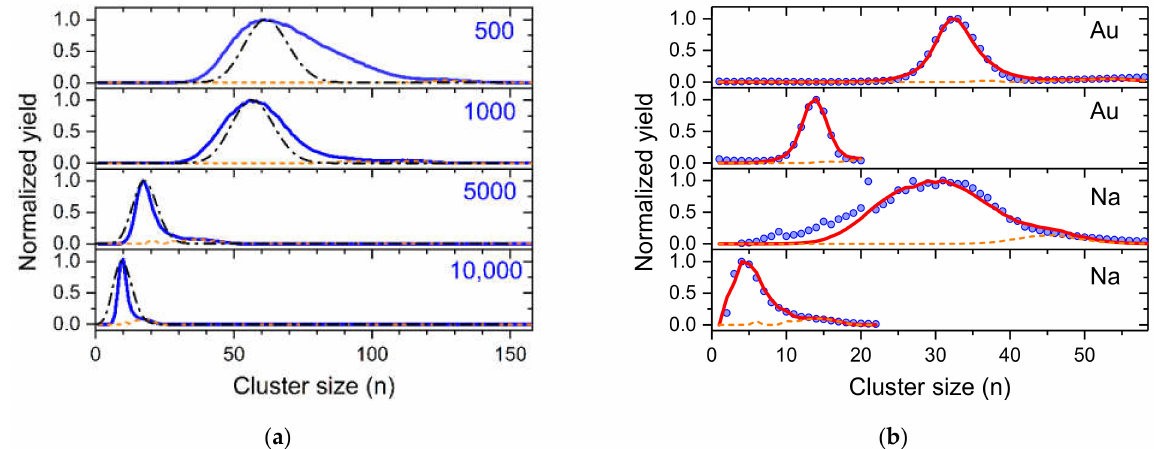
Figure 7. ( a ) Demonstration of the importance of the number of helium atoms evaporated in each doping event to the resulting cluster size distribution (see text). The values in the diagrams indicate the number of He atoms that are evaporated per dopant being picked up. The dash-dotted black lines are Poisson distributions with expectation values of the position of the maximum of the correspond- ing simulated cluster size distribution; ( b ) Comparison of experimental cluster size distributions (symbols) shown above and simulated cluster size distributions (red solid lines). The dashed orange line in both ( a , b ) indicates the last dopant cluster remaining in the droplet which under heavy doping conditions grows to considerably larger